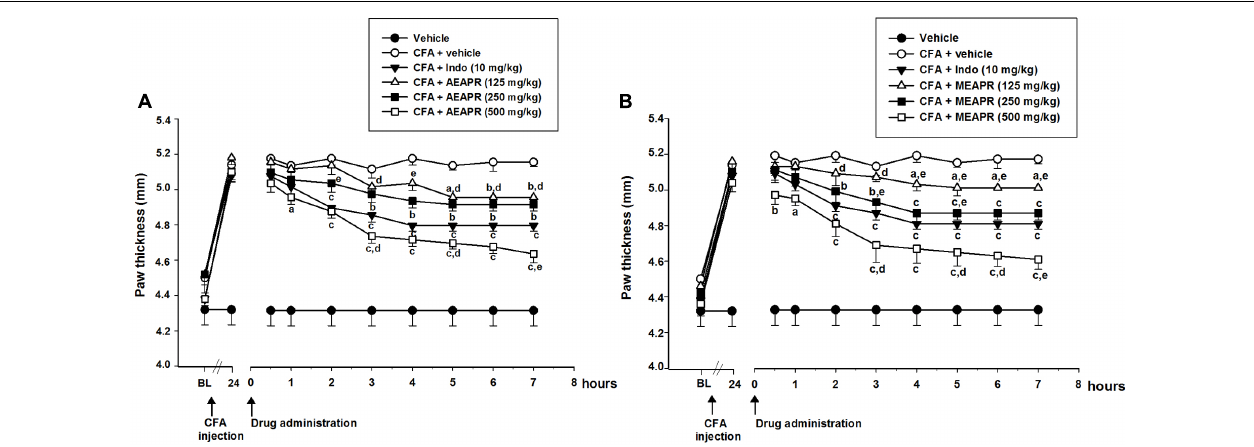
FIGURE 2 | Effect of acute administration of AEAPR (A) and AEAPR (B) on CFA-induced paw edema. Animals (six mice each group) were treated orally with vehicle (distilled water), indomethacin (Indo), MEAPR or AEAPR (125, 250, and 500 mg/kg), 24 h after intraplantar injection of Complete Freund’s adjuvant (CFA: 20 µ l). Each point represents the mean ± SEM of the paw thickness (in mm), before (basal level: BL), 24 h after the injection of CFA (time point 24 h) and at the time points indicated after drug administration. Holm–Sidak post hoc analysis; a p < 0.05, b p < 0.01 and c p < 0.001 in comparison with CFA + vehicle treated group;